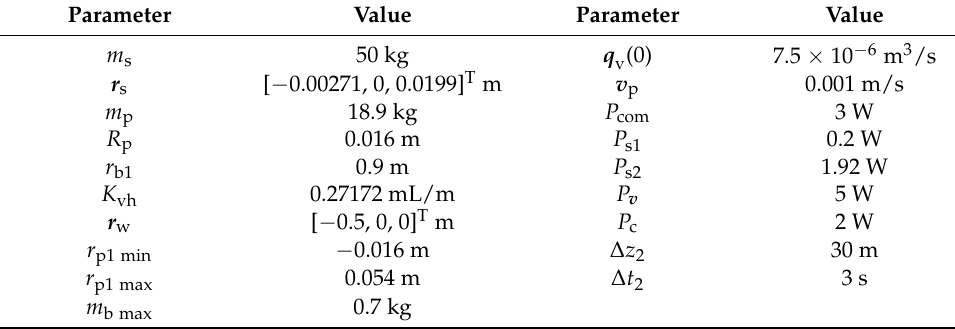
Table A1. Mass and geometric characteristic